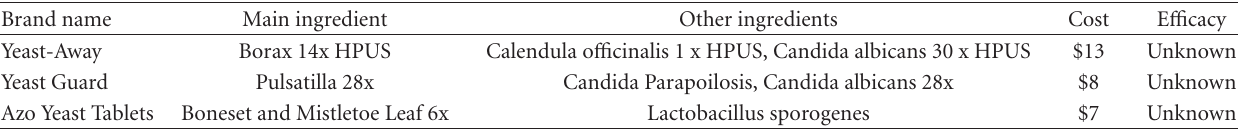
Table 5: Homeopathic